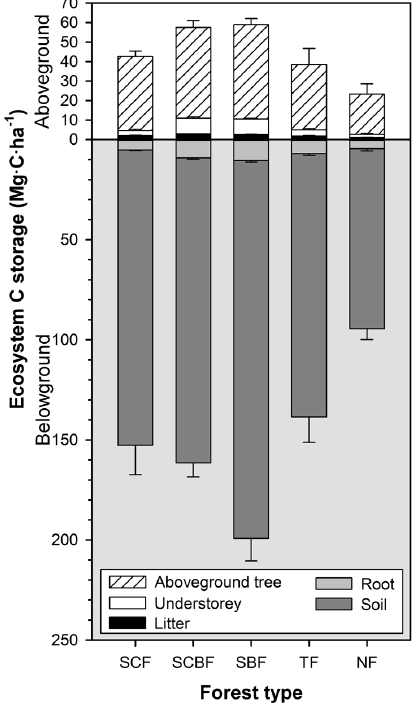
Figure 8. The total carbon stocks of different forests. Upper panel: aboveground C stock; bottom panel: belowground C stock. Vertical bars denote standard errors.